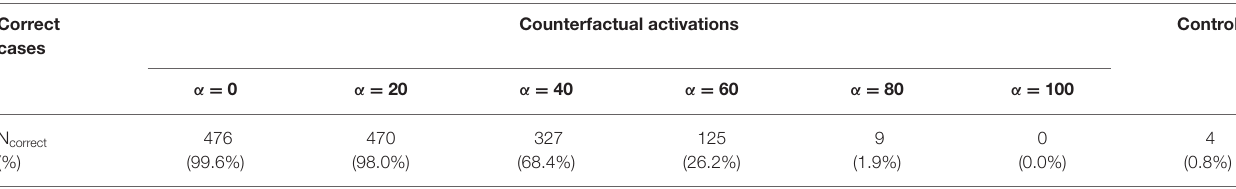
TABLE 2 | Decision of DNN classifier on counterfactual activations obtained from correctly classified brain activations. Correct cases